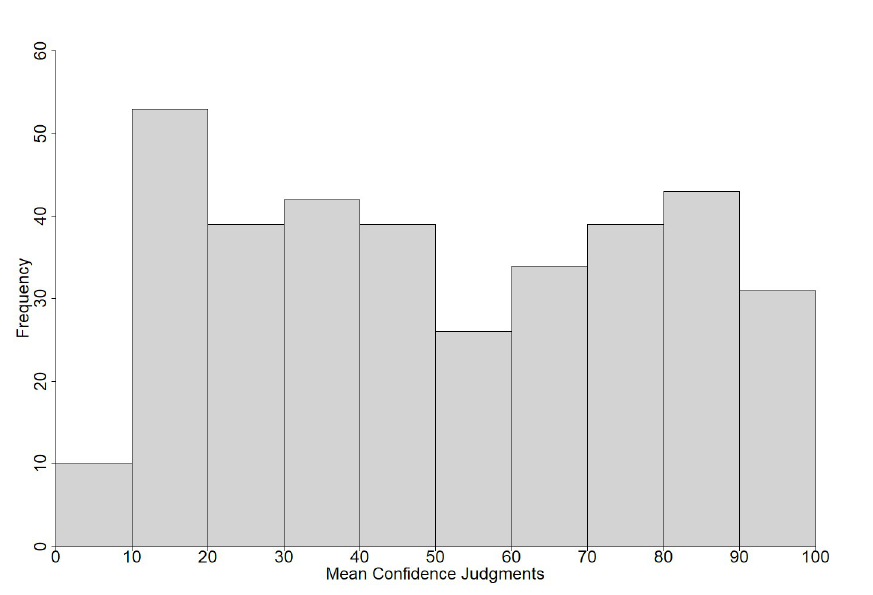
Fig 2. Histogram of the mean confidence judgments for all